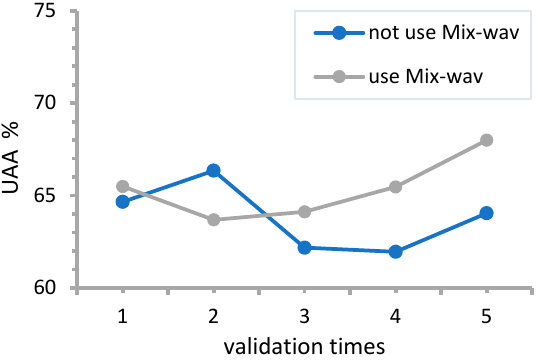
Figure 4. Comparison of tests before and after using Mix-wav on IEMOCAP.